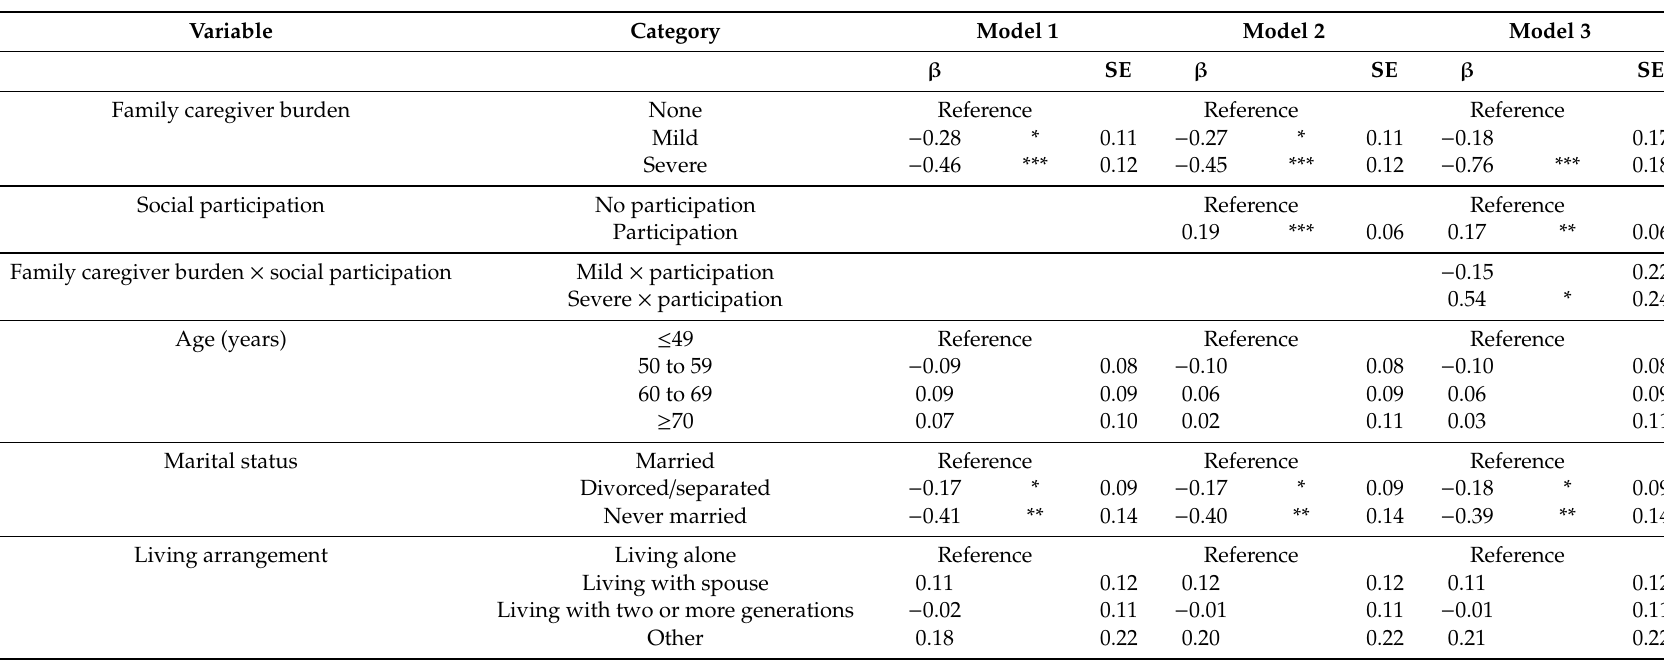
Family caregiver